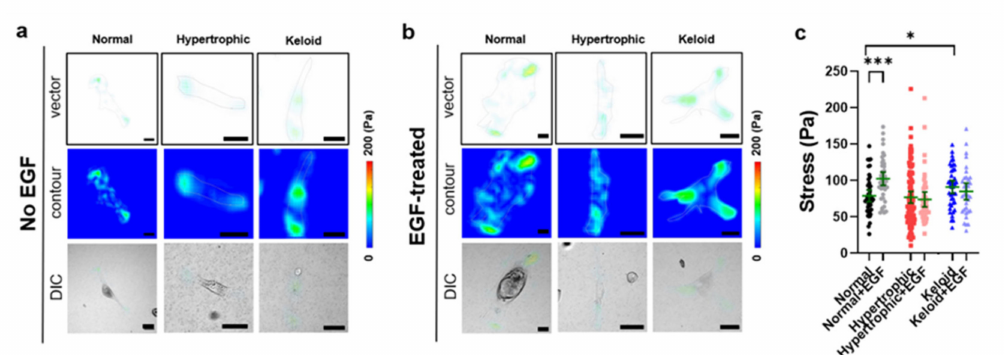
Figure 7. Characterization of the cell motility of dermal fibroblasts from NHK patient-derived scar tissues following EGF treatment. ( a ) Traction stress data from normal ( n = 44), hypertrophic ( n = 96), and keloid dermal fibroblasts ( n = 42) without EGF treatment. ( b ) Traction stress data in normal ( n = 42), hypertrophic ( n = 46), and keloid dermal fibroblasts ( n = 34) with EGF treatment. Scale bar = 50 µ m. Data represent the mean (green line) ± 95% confidence interval (green error bars). ( c ) Traction stress calculated using normal ( n = 44), hypertrophic ( n = 96), and keloid dermal fibroblasts ( n = 42). Data represent the mean (green line) ± 95% confidence interval (green error bars). * p < 0.05; *** p < 0.001 vs. normal fibroblasts without EGF